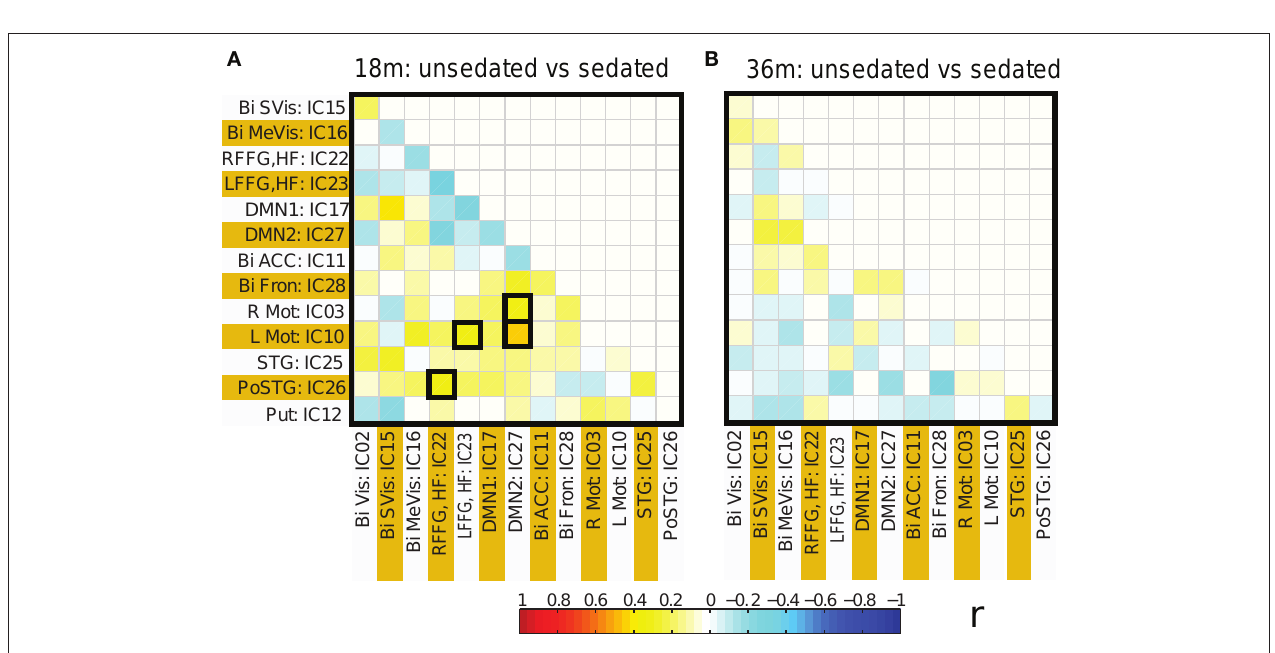
obtain mean group correlation. (B) Mean difference in connectivity (correlation) between full term and pre-term children at 18 months (left panel) and at 36 months (right panel).